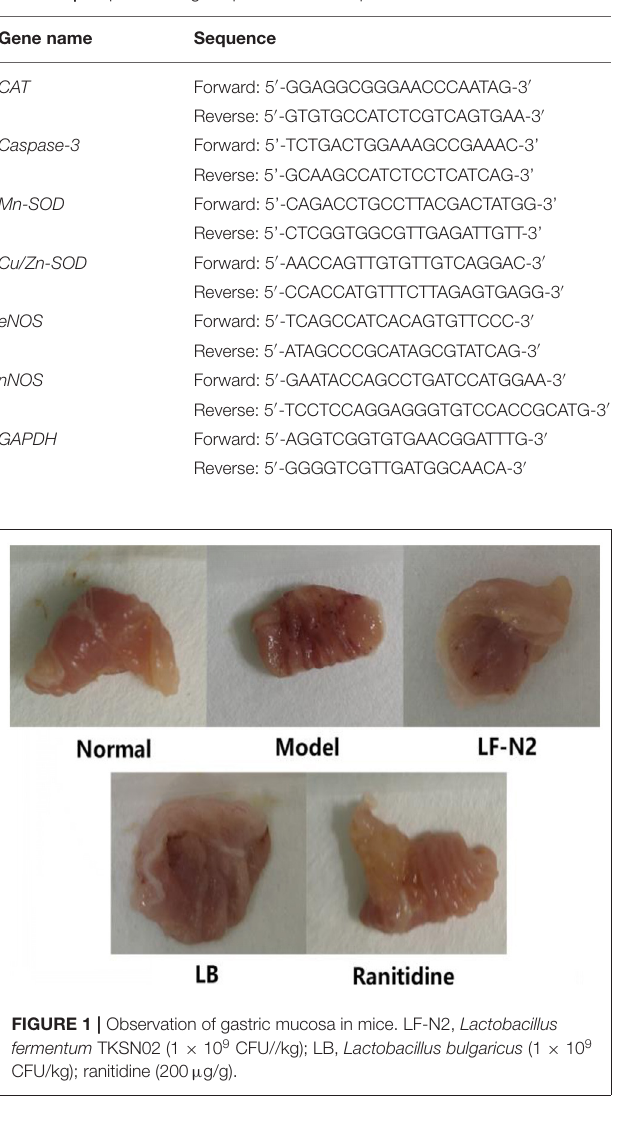
TABLE 1 | Sequences of gene primers used in qPCR.